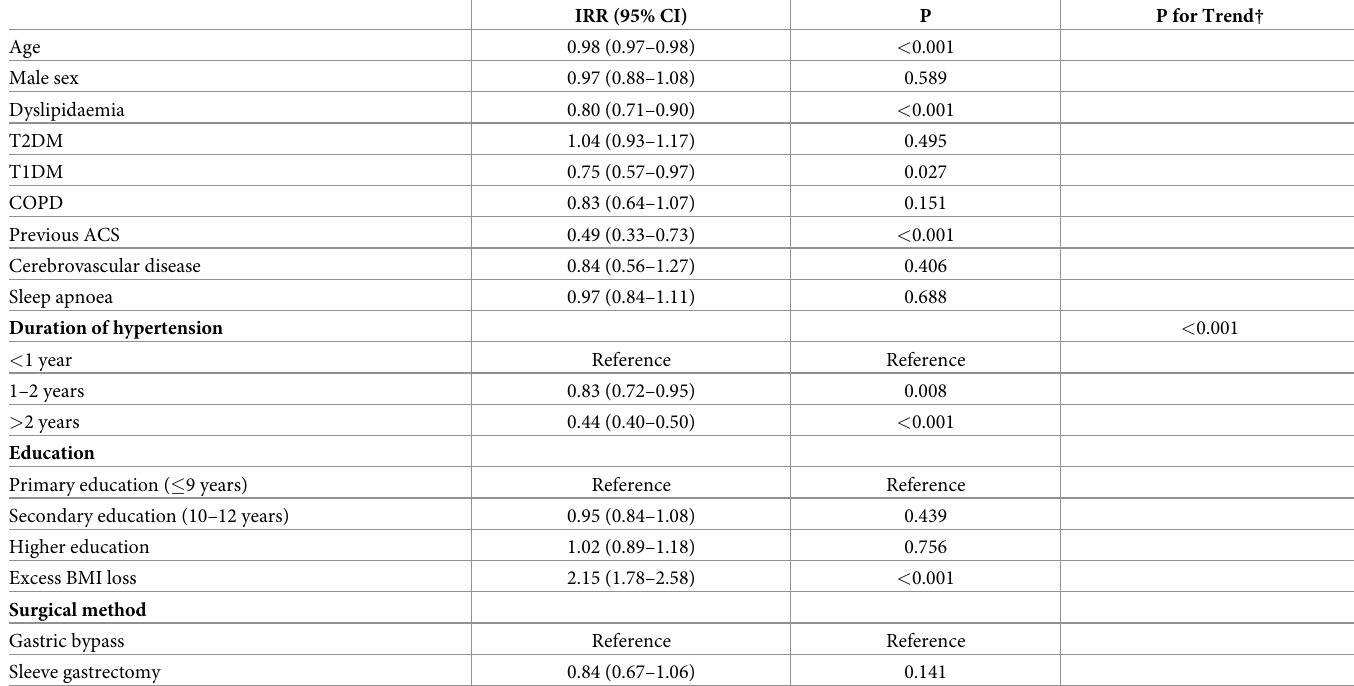
Table 3. Adjusted IRRs for reaching remission of hypertension.